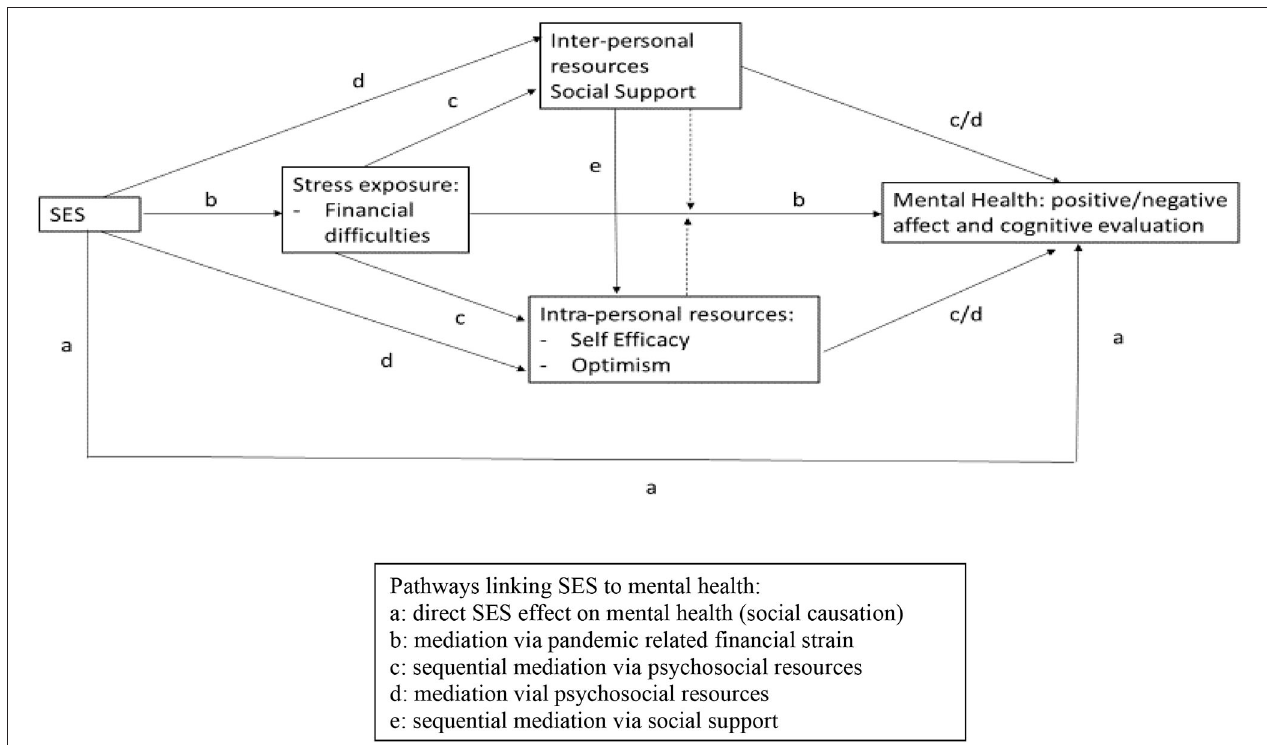
FIGURE 1 | Sequential mediating processes linking SES, financial stress, psychosocial resource factors, and mental